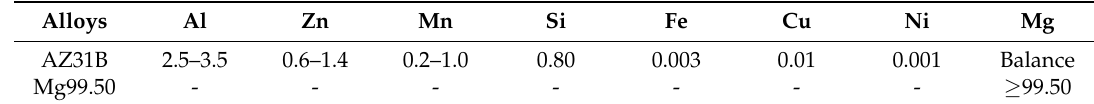
Table 1. Chemical compositions of AZ31B and Mg99.50 (in wt %).